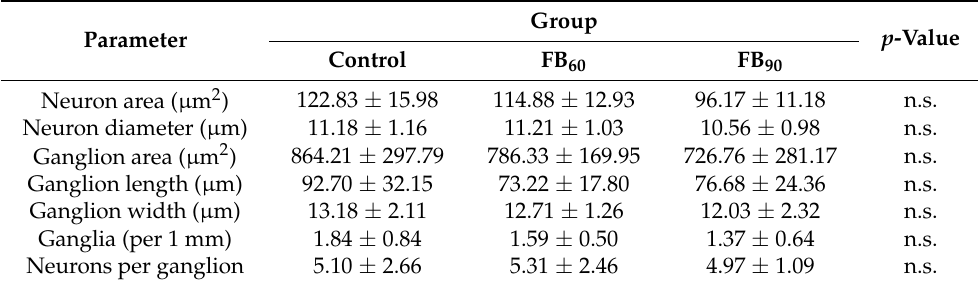
Table 2. Effect of the fumonisins intoxication on the morphology of the rat duodenal myenteric plexus (mean ± SD).